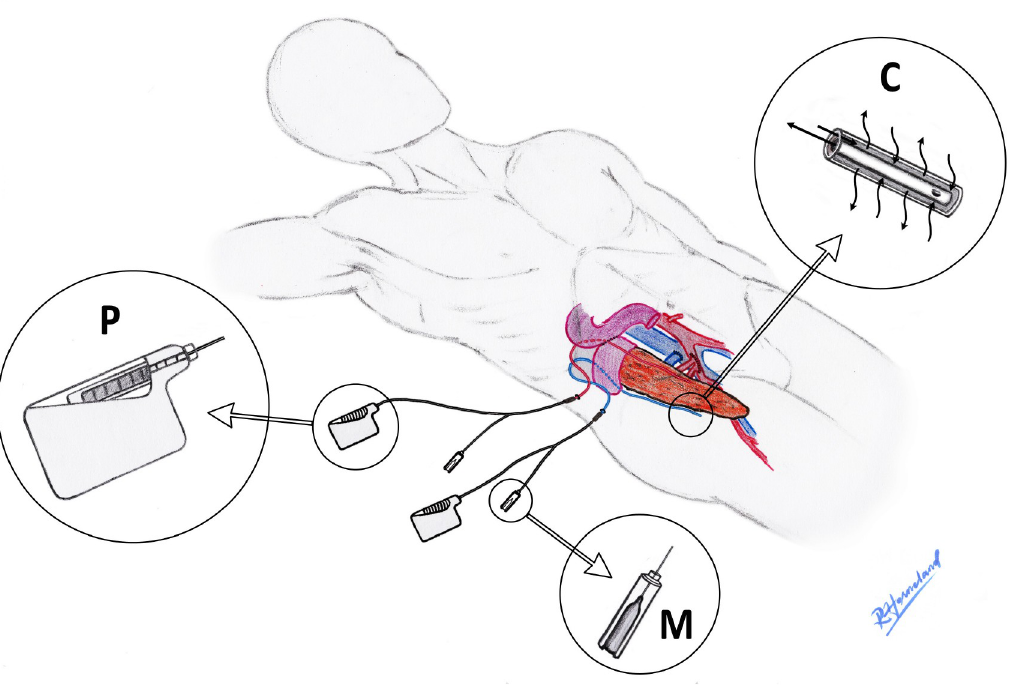
Fig 2. The microdialysis setup and placement. Microdialysis catheters positioned anterior and posterior of a pancreas transplant. The common aortic patch with both the coeliac trunk and the superior mesenteric artery was anastomosed end-to- side to the right common iliac artery. The portal vein with an iliac vein interposition graft from the same donor was anastomosed “end-to-side” to the lowermost inferior caval vein. The enteric anastomosis was performed as a hand-sewn